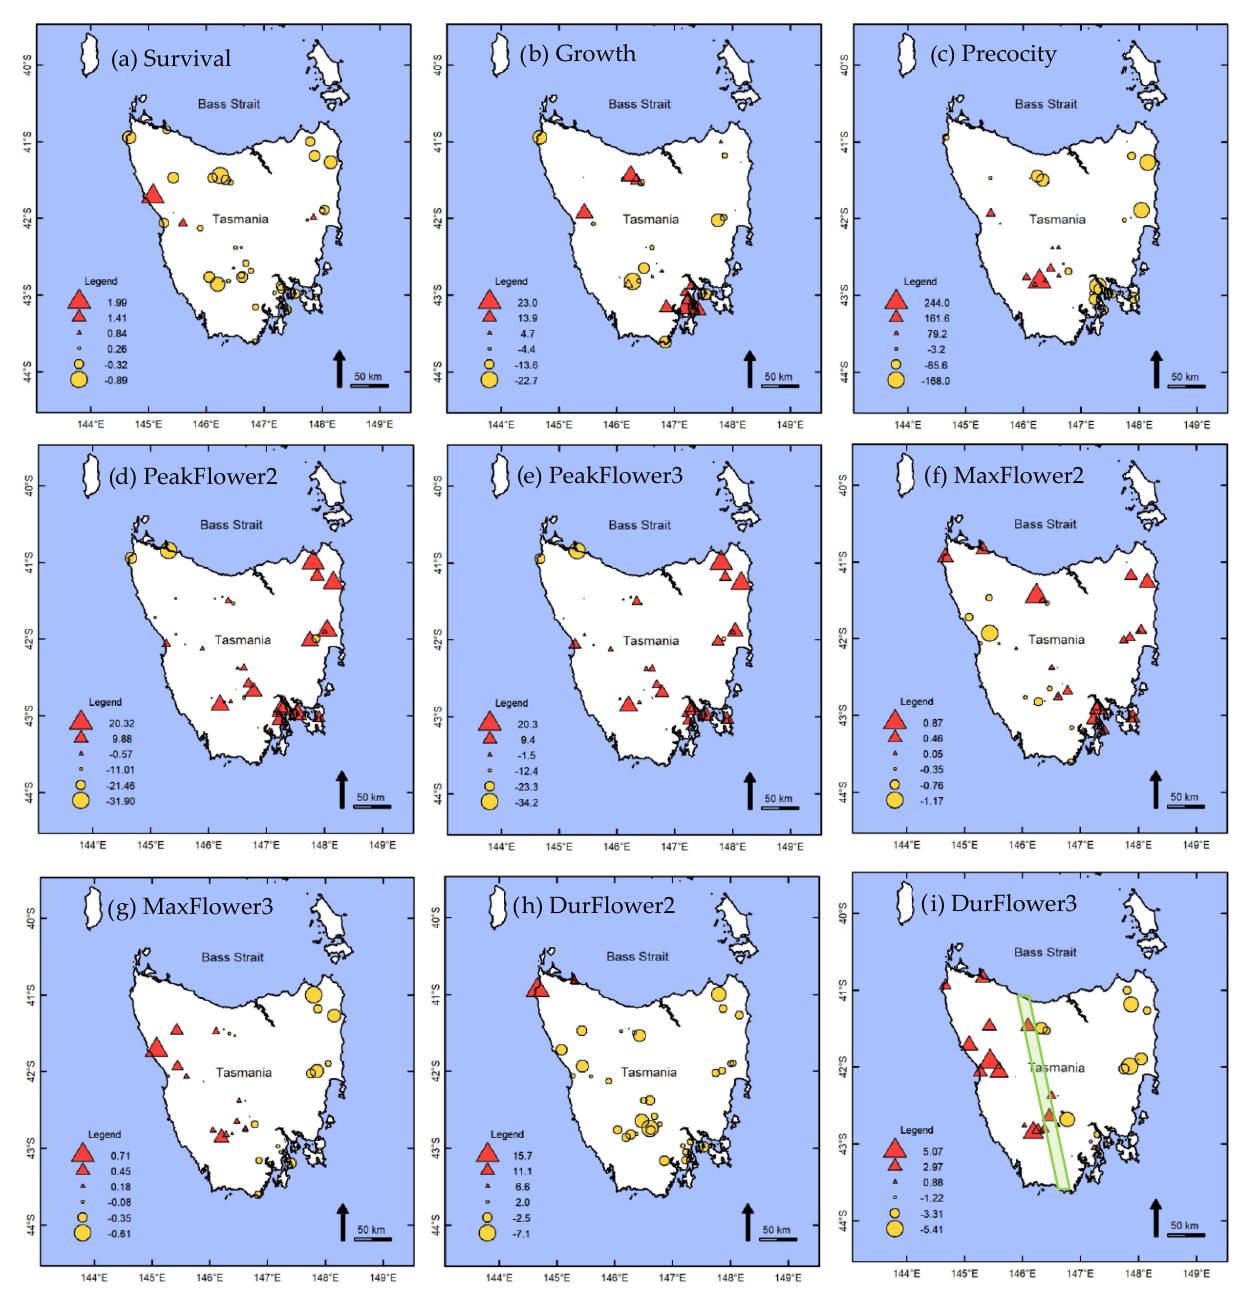
Figure 3. Geographic distribution of population BLUPs for traits of Leptospermum scoparium assessed in a common garden field trial. BLUPs are centered on the grand mean and the larger the circle or triangle, the greater the population BLUPs deviate above or below the grand mean, respectively. Tyler’s Line [48] shown in green in Figure (i).